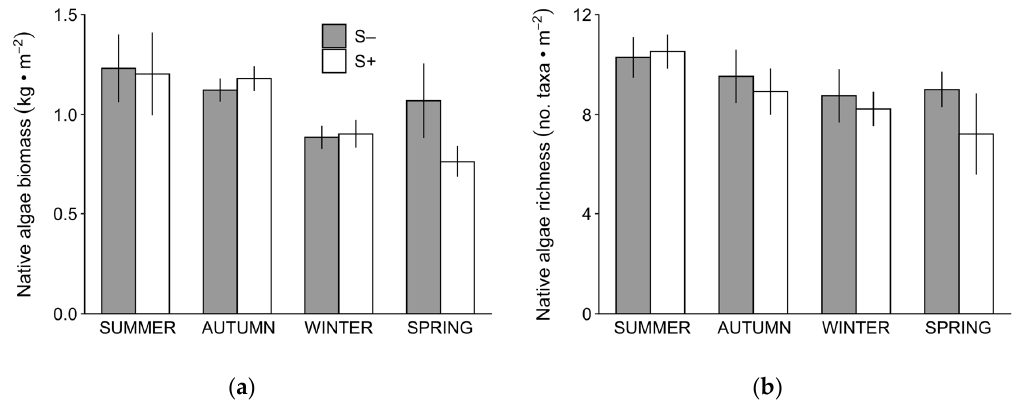
Figure 1. Mean (± SE) biomass ( a ) and taxonomic richness ( b ) of all native algae measured in Sargassum horneri -removal (S − ; grey bars) and non-removal (S+; white bars) plots. N = 4 years for summer, and 3 years for autumn, winter and spring.